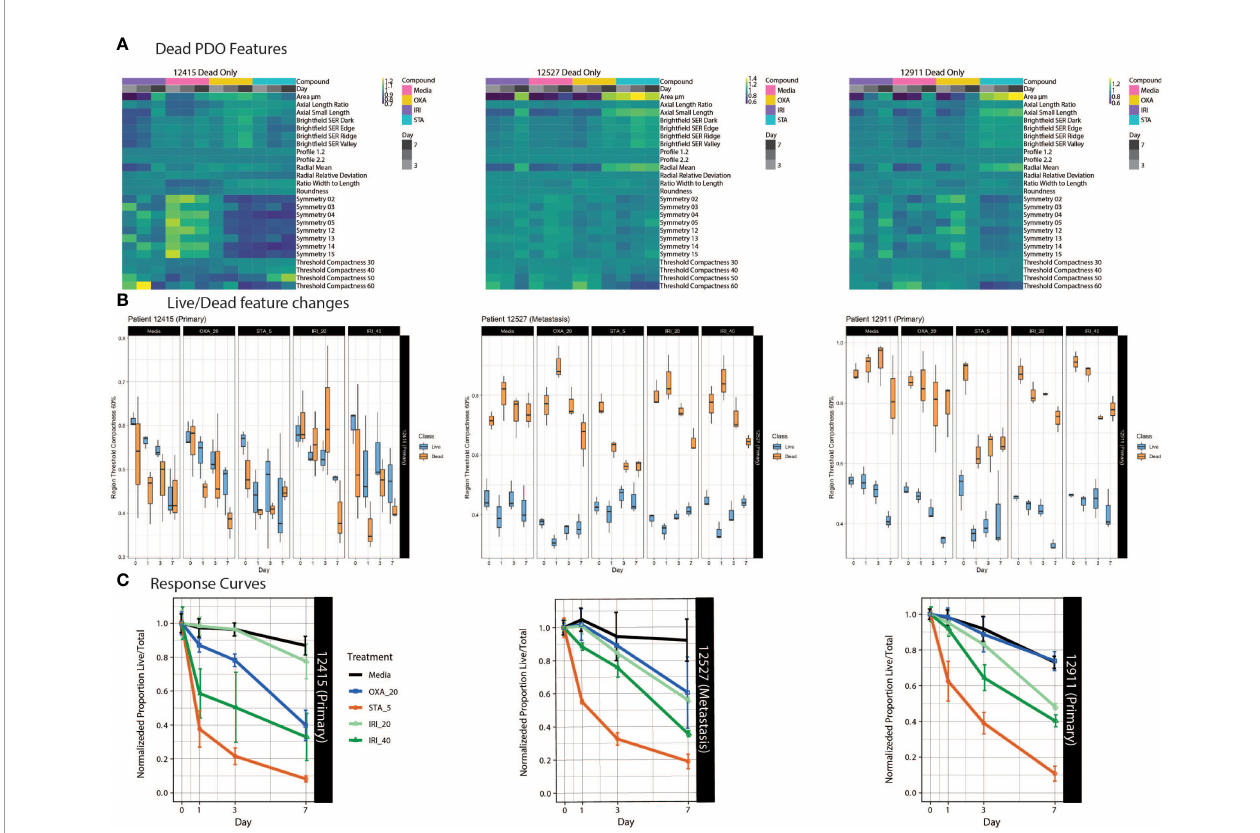
FIGURE 4 | PDO-speci fi c drug responses over time. (A) Heat maps of dead PDO features under drug perturbations. Z-score normalized averaged feature values are shown with treatment and time on the x-axis, with features on the y-axis. (B) Boxplots of the feature “ region threshold compactness 60% ” generated using the Organoizer show the variation between the classi fi ed live/dead groups. (C) Fractions of live/total organoids from untreated media control, irinotecan-treated and oxaliplatin-treated groups are plotted over time to generate dose response curves. Points indicate the mean and bars show the